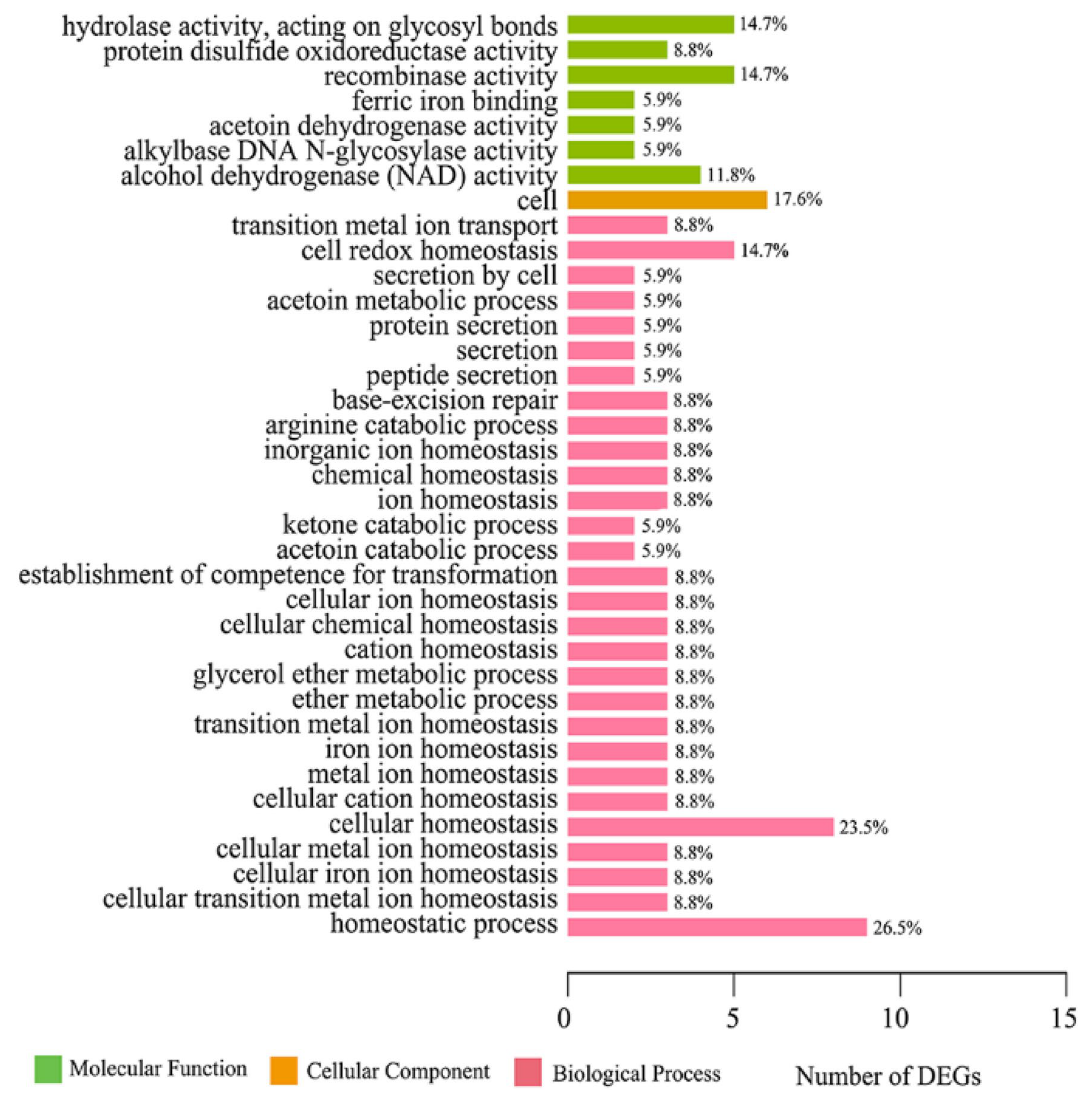
Figure 5. Gene Ontology (GO) enrichment analysis of 281 differentially expressed genes. The top three enriched terms in the category of biological process (BP) were homeostatic process, cellular homeostasis and cell redox homeostasis. In the category of cellular component (CC), cell was the only enriched term. The terms of hydrolase activity, acting on glycosyl bonds, recombinase activity, and alcohol dehydrogenase (NAD) activity were dominant in the molecular function category